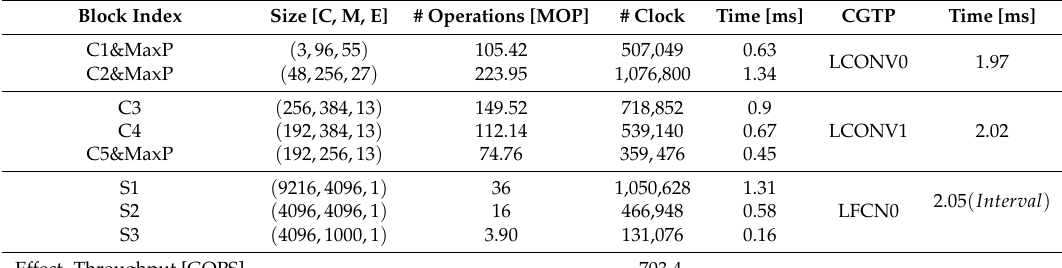
Table 4. Processing time and other details of individual stages of AlexNet at 800